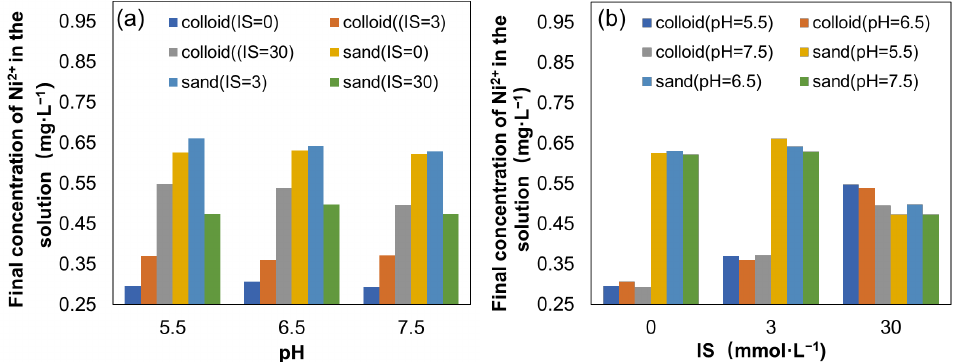
Figure 3. Effect of pH and ion strength (IS) on the adsorption of Ni 2+ on the soil colloids and quartz sand ( a ) pH effect; ( b ) IS effect. The initial concentration of Ni 2+ was 0.6628 mg·L − 1 , different ISs were adjusted with NaNO 3 , the concentration of soil colloids was 220 mg·L − 1 , different pHs were adjusted with 0.1 M HNO 3 or 0.1 M NaOH, the equilibrium time was 24 h.